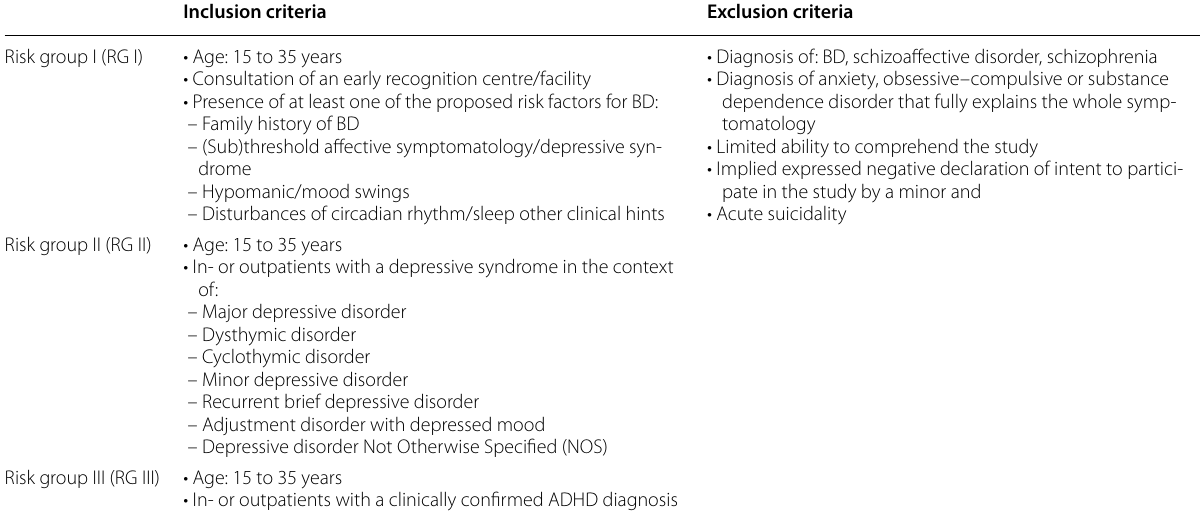
Table 1 Key inclusion and exclusion criteria for study participants of the risk groups I–III Inclusion